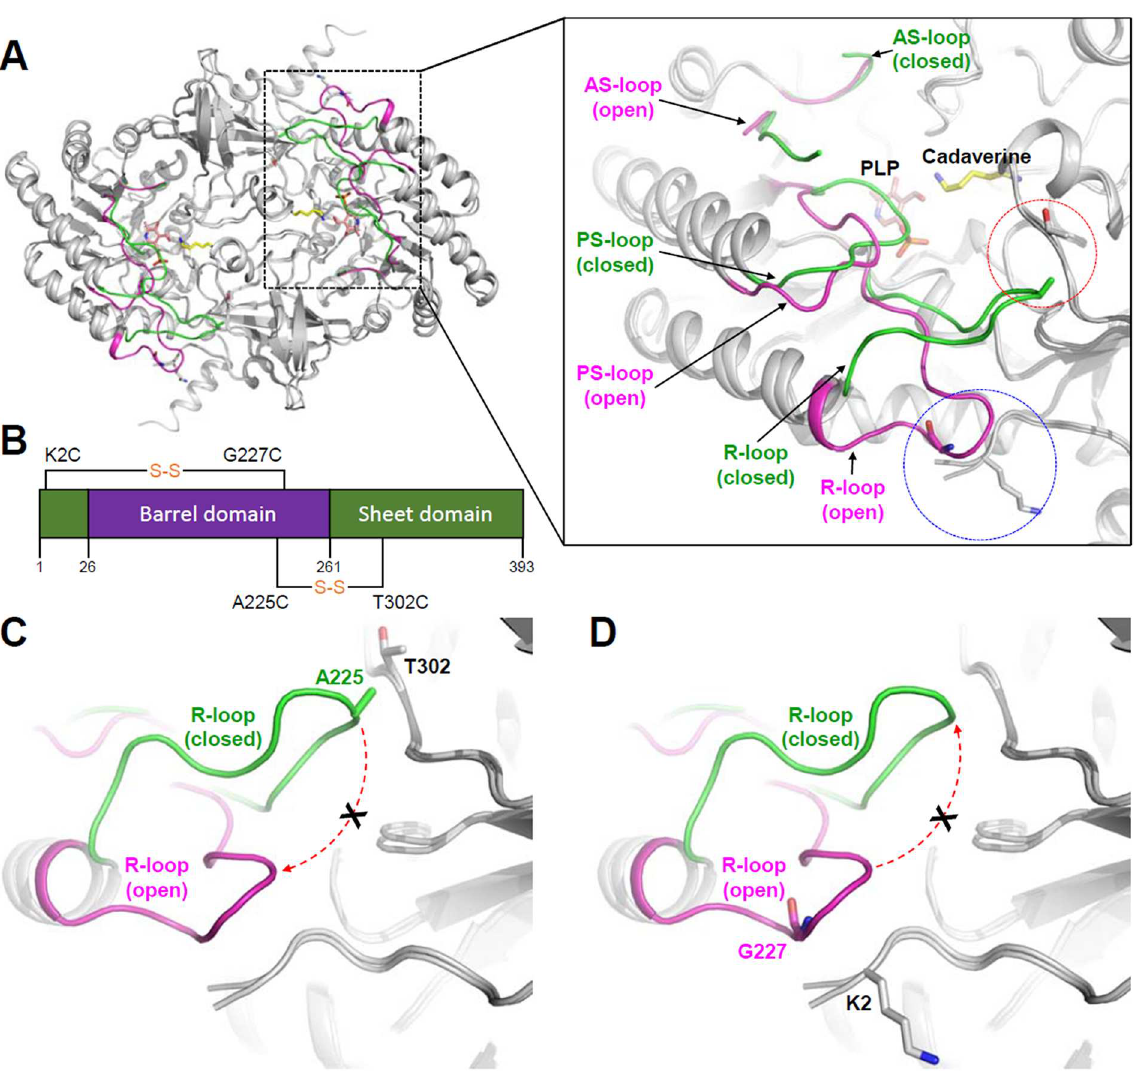
Fig 1. Rationale of introduction of an artificial disulfide bond in Sr LDC. ( A ) Open/closed conformational changesat the PLP bindingsite of Sr LDC. The openand the closed conformations of Sr LDC are superimposed and shown as a cartoon diagramwith green and magentacolors, respectively.The right side figure is an amplification of the dotted-boxof the left figure. The AS-loop, PS- loop and R-loopof the open and the closed conformations of Sr LDC are labeled.The boundPLP and cadaverineare shown as stick models and labeled.The target residuesfor the introductionof a disulfidebond are indicatedwith dotted-circle. ( B ) Schematicof the introduced disulfidebondsin Sr LDC. The sheet domain and barrel domainare presented with green and purplecolors, respectively. The residues replaced by cysteines to introducea disulfidebond are presentedwith black line and labeled.( C ) ( D ) A rationaleof introduction of a disulfidebond. The open and the closed conformations of Sr LDC are superimposed and shown as a cartoon diagram. The R-loopof the open and closed conformation of Sr LDC are presented with cartoon diagrams with the same color scheme with ( A ). The residuesselectedto generatethe Sr LDC A225C/T302C mutant ( C ) and the Sr LDC K2C/G227C mutant ( D ) are shown as stick models and